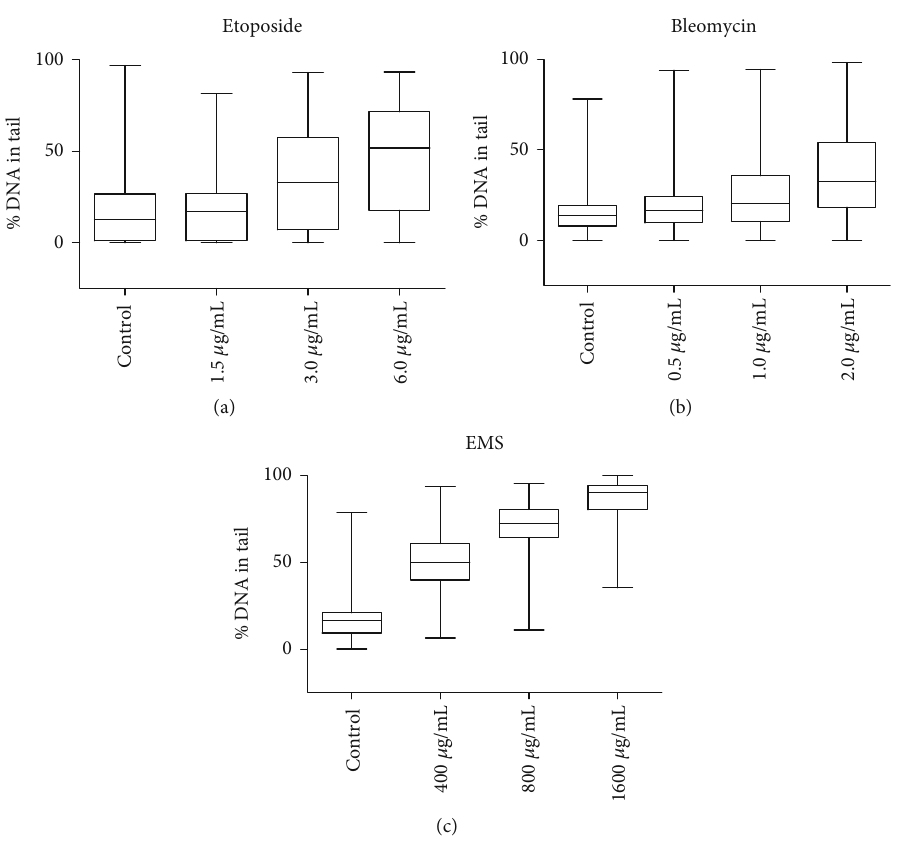
Figure 2: Comet assay — comparison of treatment with (a) etoposide, (b) bleomycin, and (c) EMS. The data are plotted as box and whiskers, which indicates the 25 and 75 percentiles as the size of the data box, the median % DNA as a horizontal line within the boxes, and the outliers by the max and minimum values of the vertical lines. Approximately 100 cells were counted at each treatment level. The data are from one of three